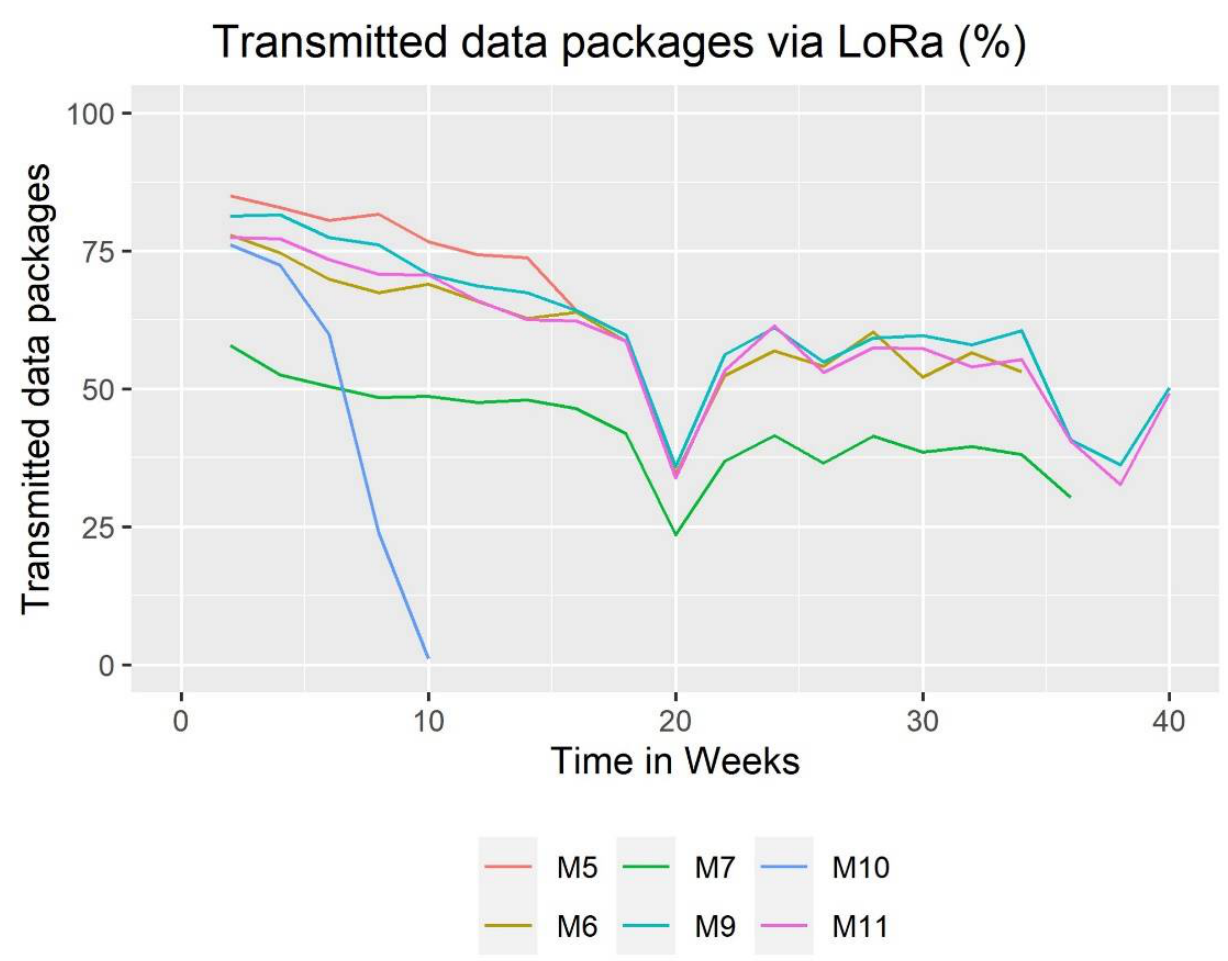
Figure 5. Data transmission rates in percent of LoRa nodes in trial 3 over a time span of 40 weeks. With the exception of M5 and M10, all nodes stop transmission when being extracted in feed-out phase. Battery of M5 was low by the 15th week of trial.